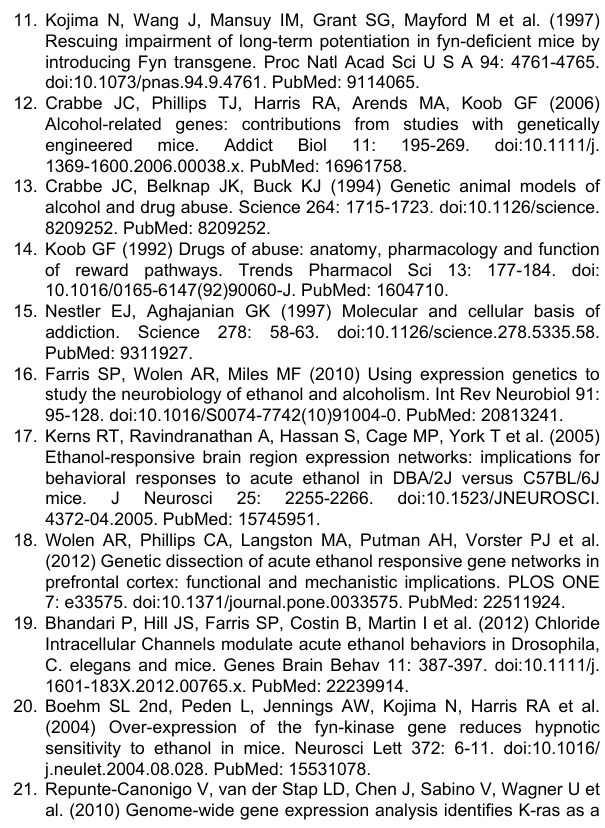
Table S6. Gene list from analysis of Fyn or LORR expression correlations for ethanol-responsive expression data as described in Figure 4A. Data are the 32 genes contained in Figure 4C network. Genes have significant correlations with ethanol-responsive Fyn expression in the PFC BXD and LXS datasets, correlate with ethanol LORR behavioral data and have altered responsive expression in PFC between control and Fyn null animals. Values are Pearson correlations and corresponding p-values. Correlations were performed from databases within the GeneNetwork web resource.